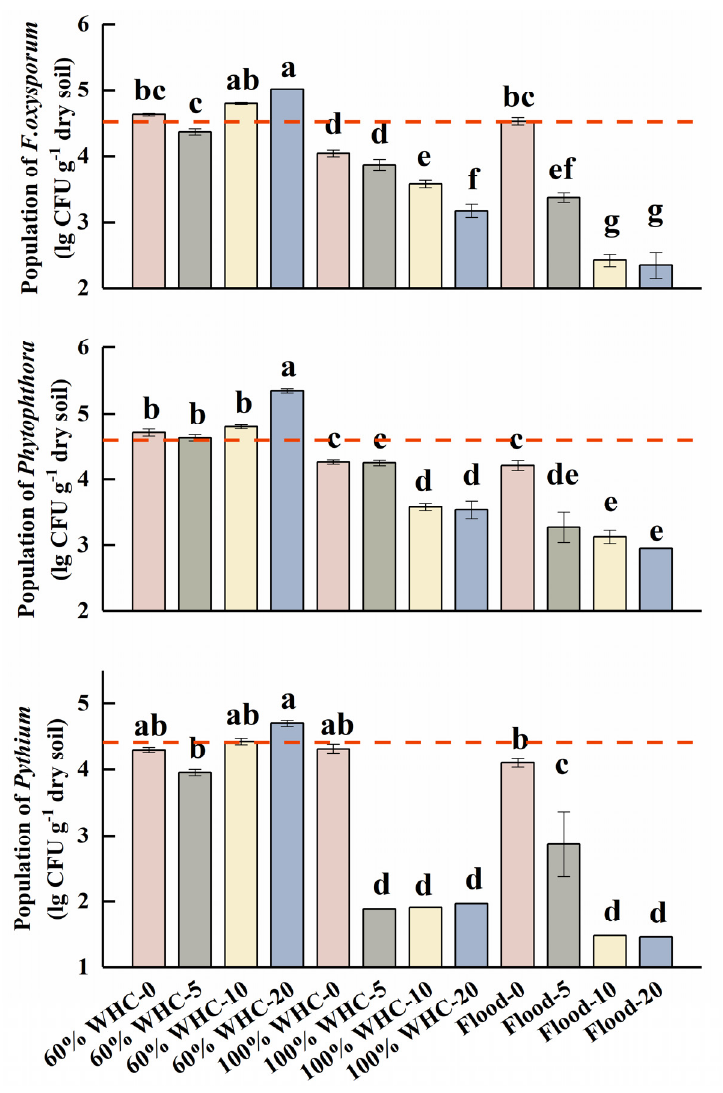
Figure 4. The populations of F. oxysporum , Phytophthora and Pythium in soils after RSD treatment. Error bars indicate standard deviation. Different lowercase letters show significant differences among the various treatment (SNK tests, p < 0.05). The dashed lines represent the initial value of the original soil.